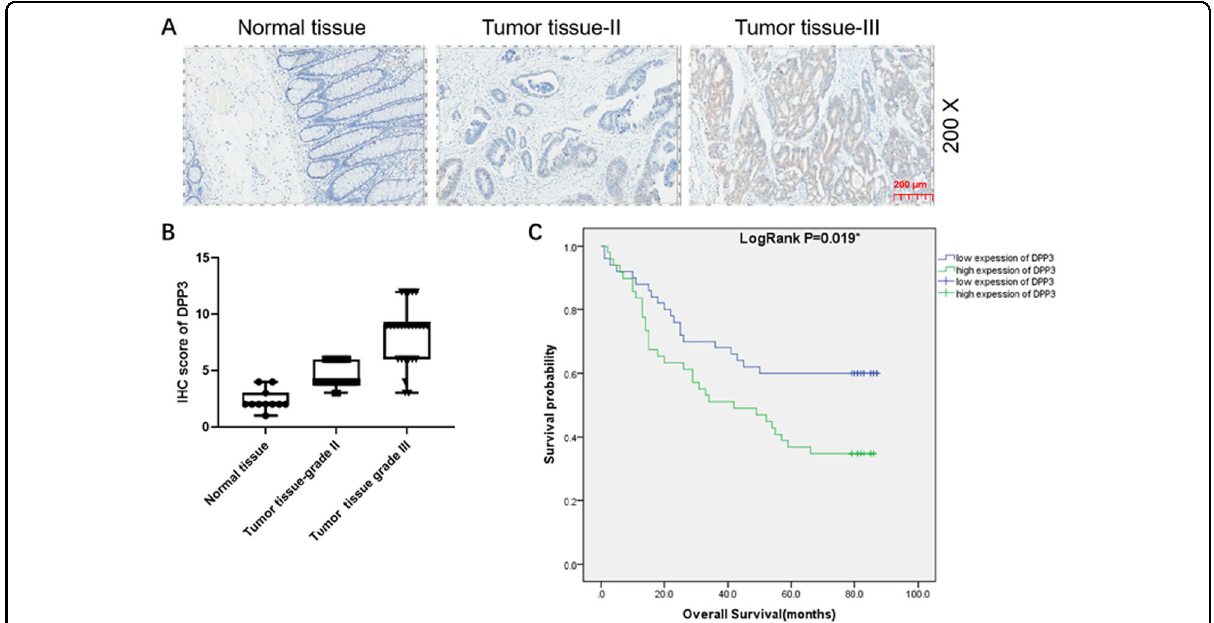
Fig. 1 DPP3 was upregulated in CRC and knockdown of DPP3 cells models was constructed. A , B The expression level of DPP3 was detected by IHC analysis in normal tissues and CRC tissues with different T stage. C Kaplan – Meier survival analysis was performed to establish the relationship between DPP3 expression and prognosis of CRC patients. The representative images were selected from at least three independent experiments. Data were shown as mean ± SD. * P < 0.05, ** P < 0.01, *** P <